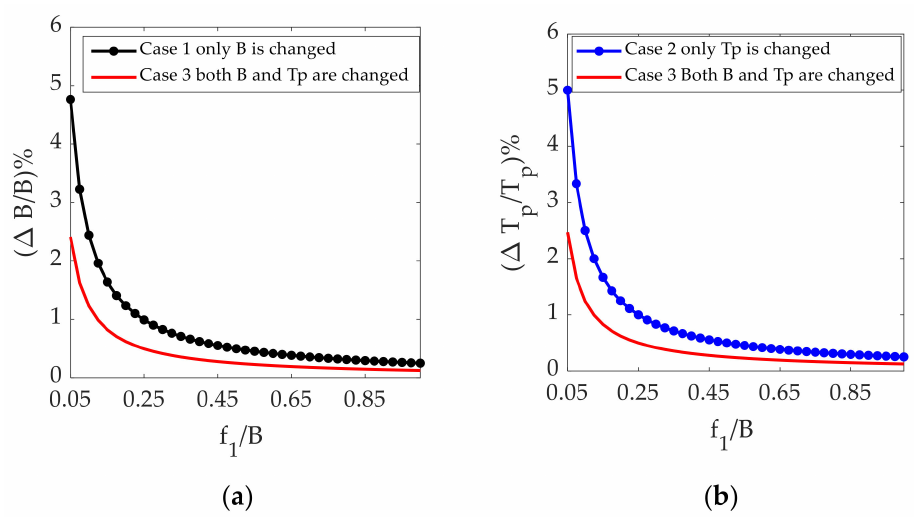
Figure 3. Analysis results of different jamming strategies: ( a ) ratio of bandwidth variation to bandwidth of signal vs. sampling frequency shift relative to bandwidth; ( b ) ratio of pulse width variation to pulse width of signal vs. sampling frequency shift relative to